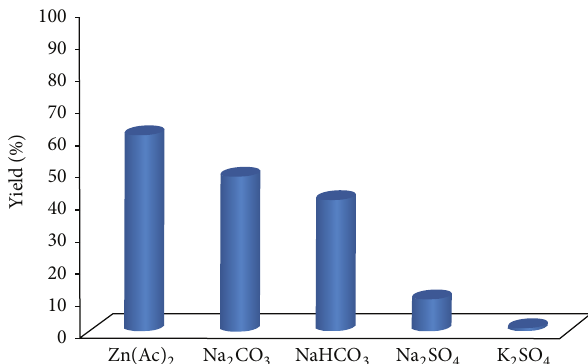
Figure 7: The effect of EG: PET molar ratio on BHET yield (196 ∘ C, PET:catalyst molar ratio 380 :1, 1 hr) [8].